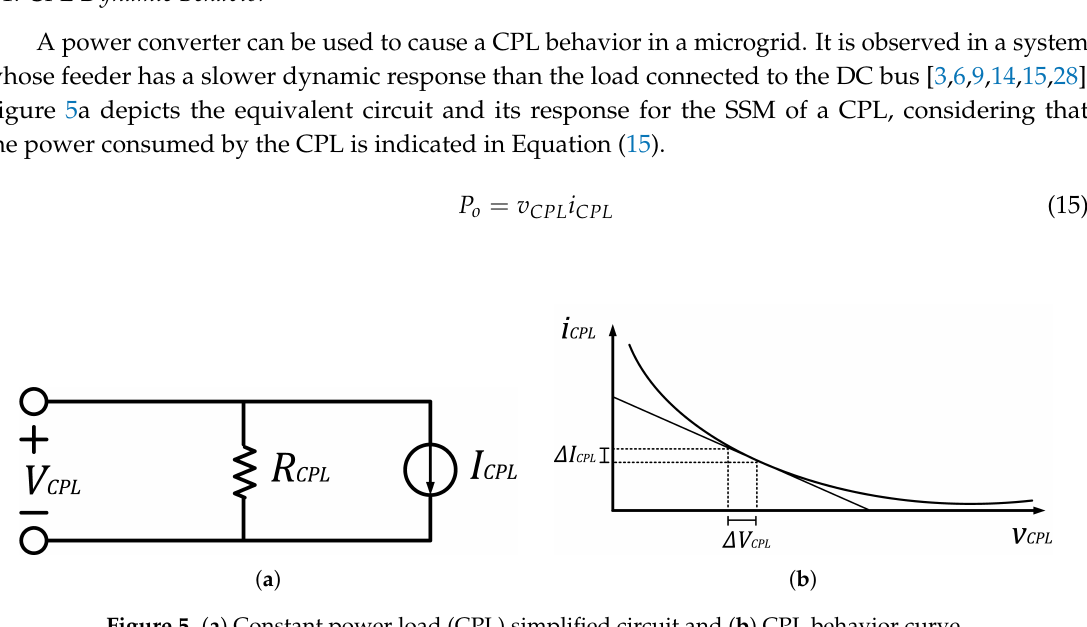
Figure 5. ( a ) Constant power load (CPL) simplified circuit and ( b ) CPL behavior